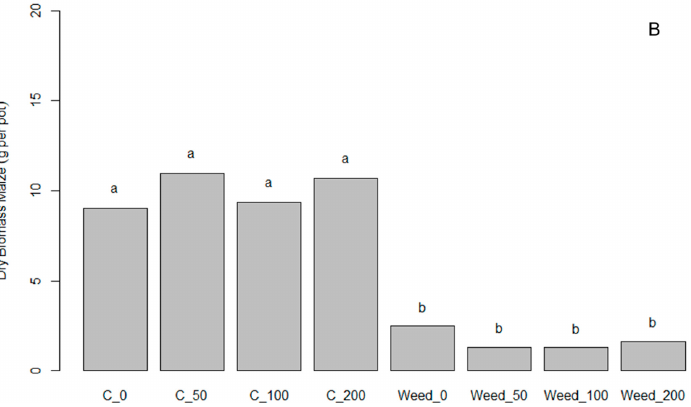
Figure 6. Maize biomass (g pot − 1 ) in response to weed competition and ComCat ® application at 50, 100, and 200 g ha − 1 at Hohenheim 2020, 43 days after sowing in the experiments ( A , B ). A rate of 100 g ha − 1 corresponds to the recommended field rate. C = weed-free control, Weed = 20 plants per pot transplanted at time of maize emergence. Means with the same letters above the columns do not differ significantly based on Tukey’s HSD test ( p ≤ 0.05).